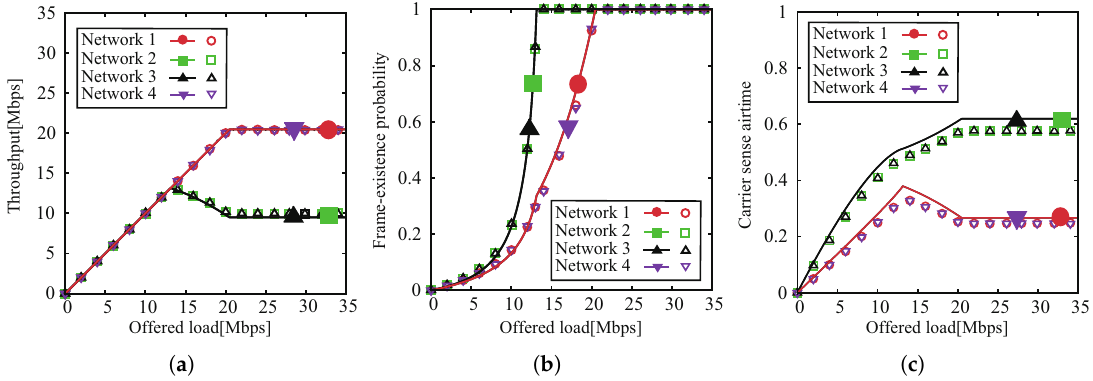
Figure 6. Network characteristics of analytical (lines) and simulation (plots) results as a function of the offered load for Scenario 2. ( a ) Throughput. ( b ) Frame-existence probability. ( c ) Carrier-sense